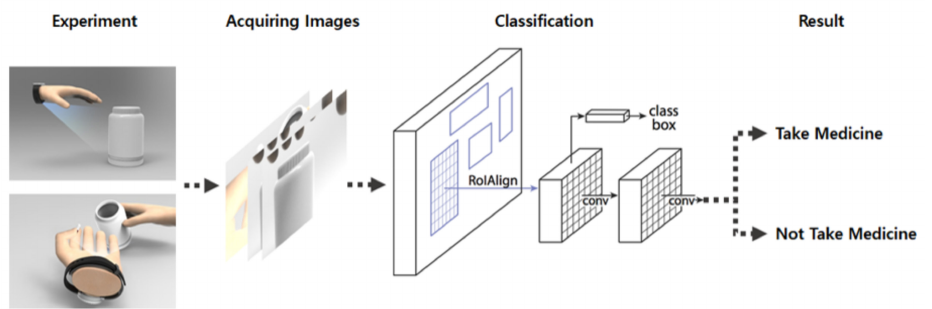
Figure 6. Experimental model for medication behavior